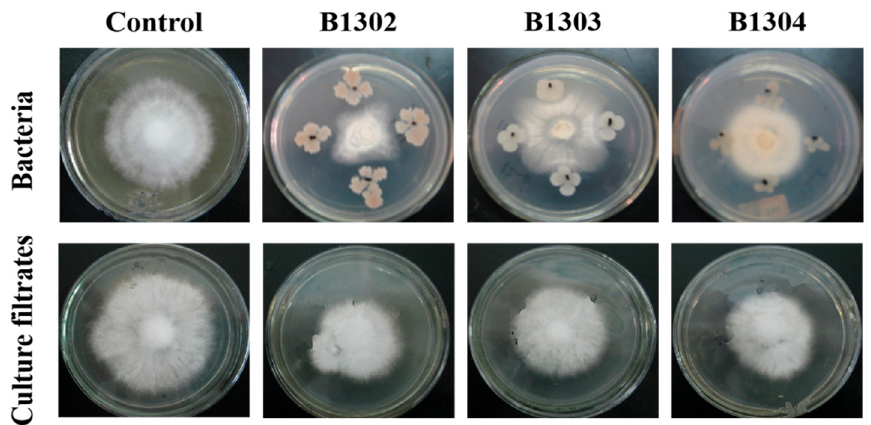
Figure 1. Inhibitory effects of bacteria B1302 and its culture filtrate on R. cerealis on PDA.